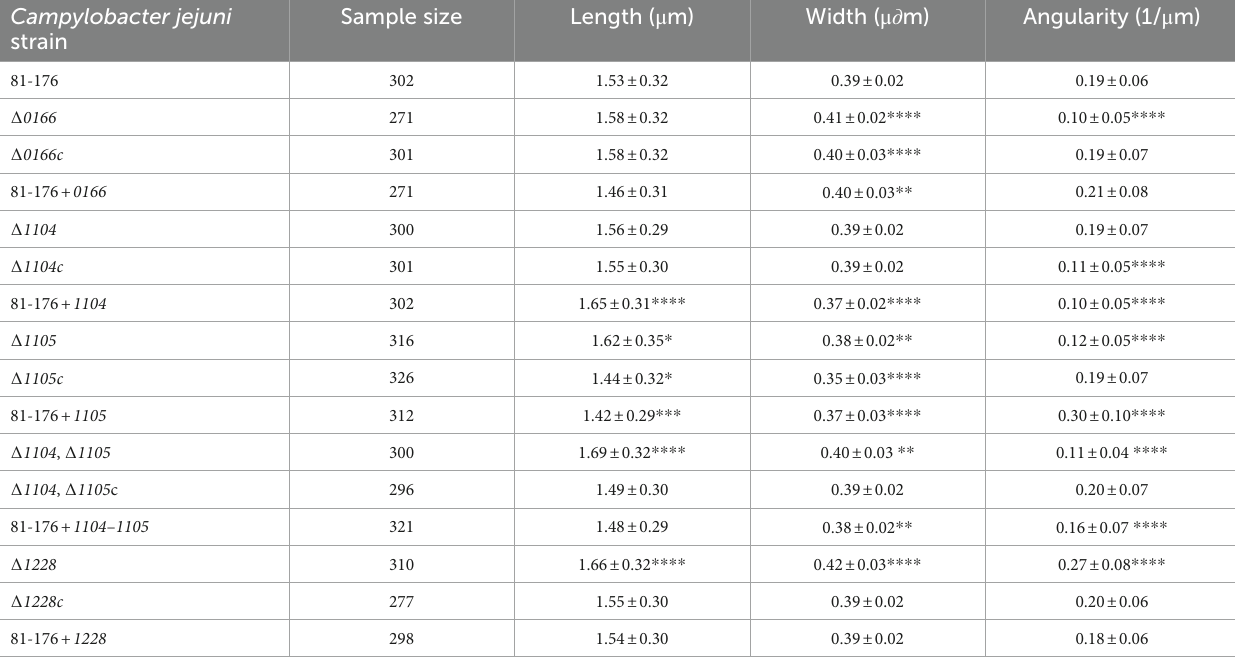
TABLE 1 MicrobeJ quantitative analysis of cell morphology parameters of Campylobacter jejuni wild-type 81-176, ∆ 0166 , ∆ 1104 , ∆ 1105 , ∆ 1104 ∆ 1105 , and ∆ 1228 mutant strains, complemented strains ∆ 0166 c, ∆ 1104 c, ∆ 1105 c, ∆ 1104 , ∆ 1105 c, and ∆ 1228 c, and overexpression strains 81-176 + 0166 , 81– 176 + 1104 , 81–176 + 1105 , 81–176 + 1104 – 1105 , and 81-176 + 1228 .